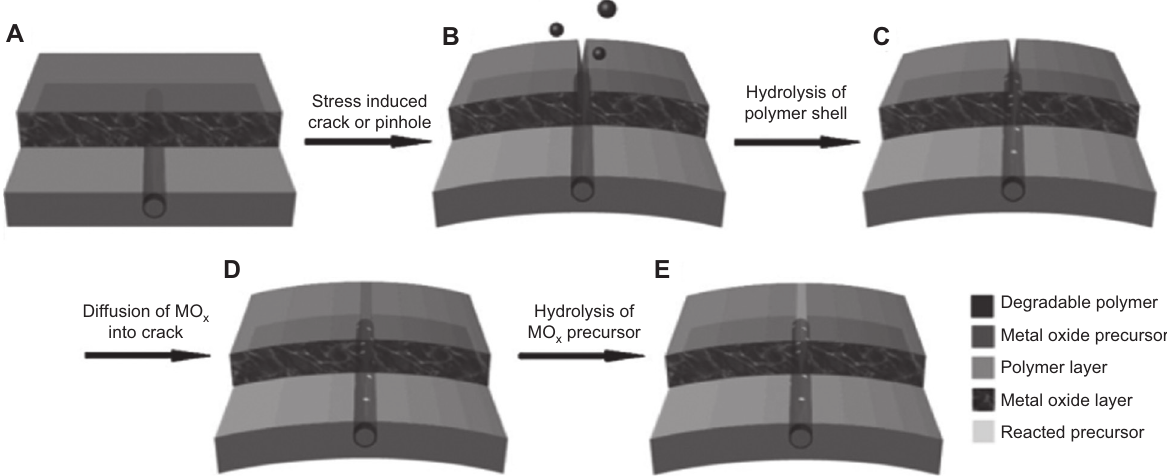
Figure 8 Schematic diagram of the healing mechanism. (A) Undamaged polymer layer containing fibers with reactive metal oxide precur- sor, (B–D) healing occurs over four steps, and (E) healing nanocomposite (reprinted with permission from [39]). Copyright 2008, John Wiley and